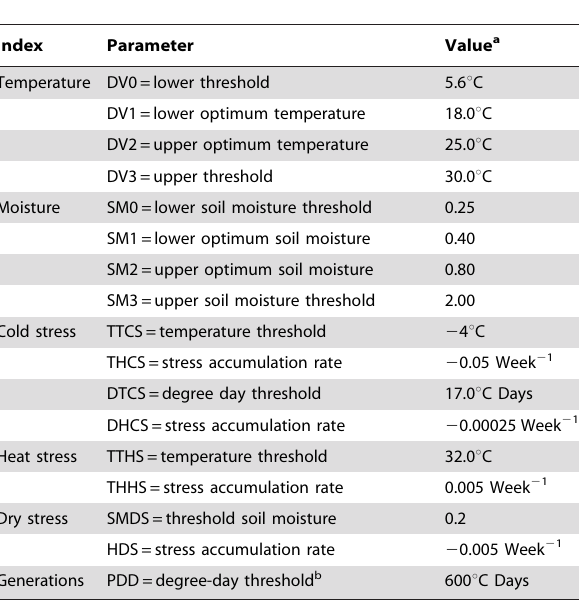
Table 1. CLIMEX parameter values used for Thaumetopoea pityocampa . Parameter mnemonics are taken from Sutherst et al.